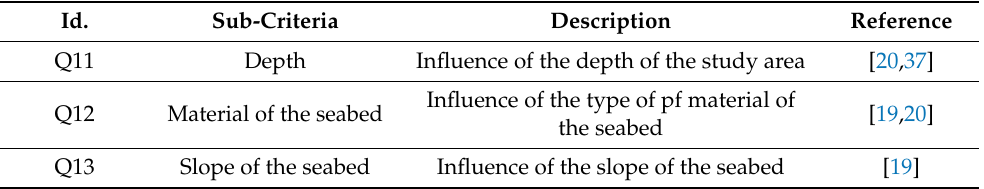
Table A3. Block 2: Influence of the nature of the seabed and the location where the WEC device is intended to be placed. Q11 to Q13.